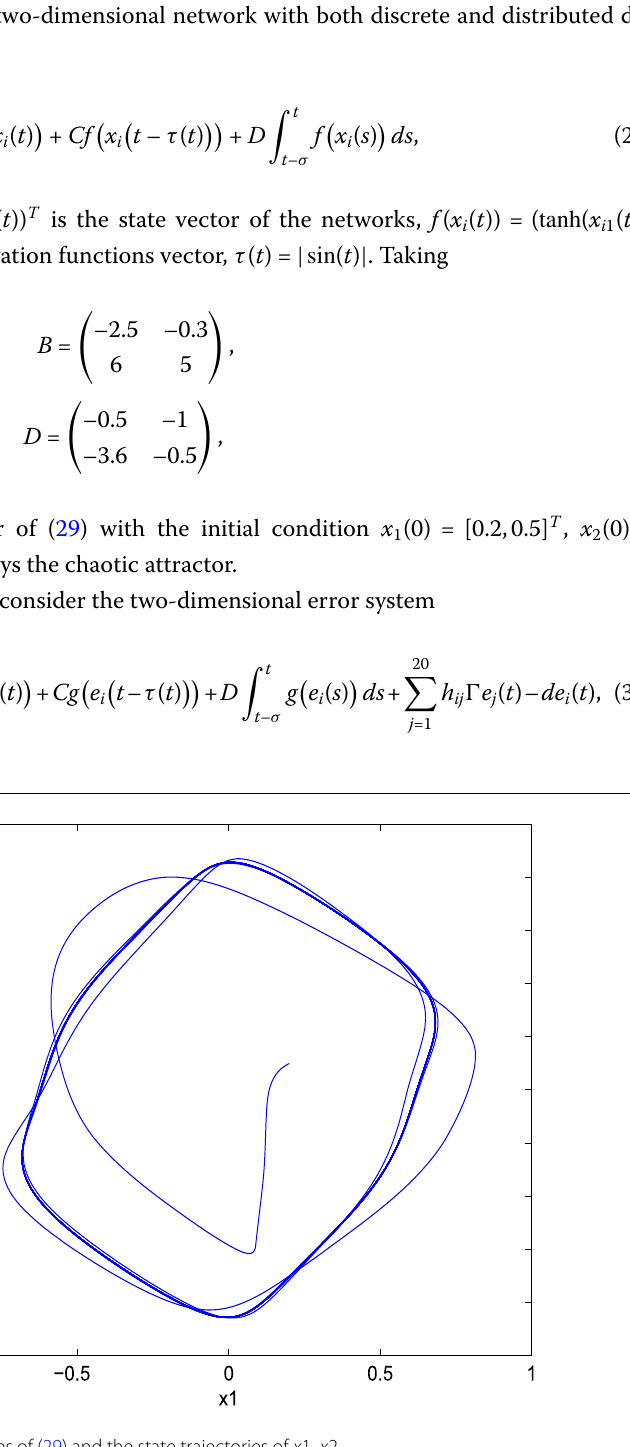
Figure 1 Attractor trajectories of (29) and the state trajectories of x 1, x